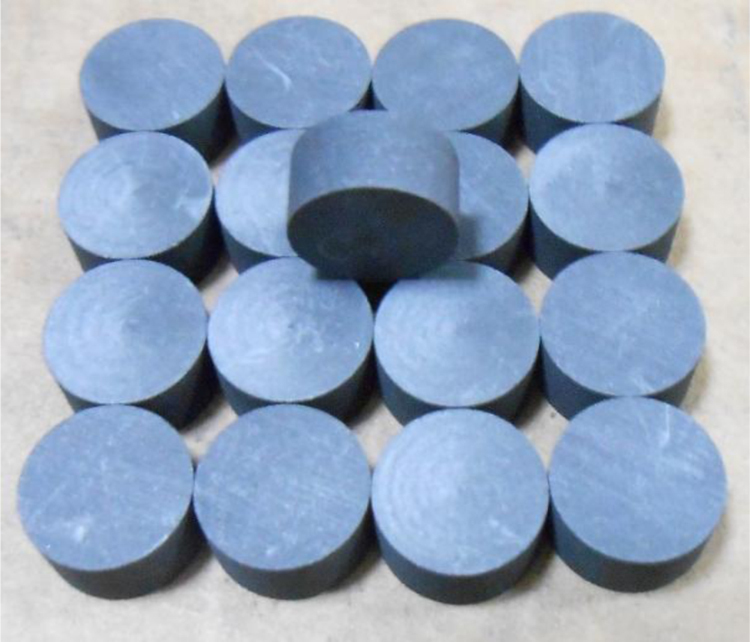
The picture of tension samples (NG-CT-10, Φ10.0 × 5.0 mm).